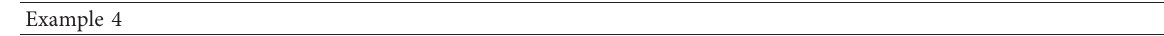
Table 6: The publications